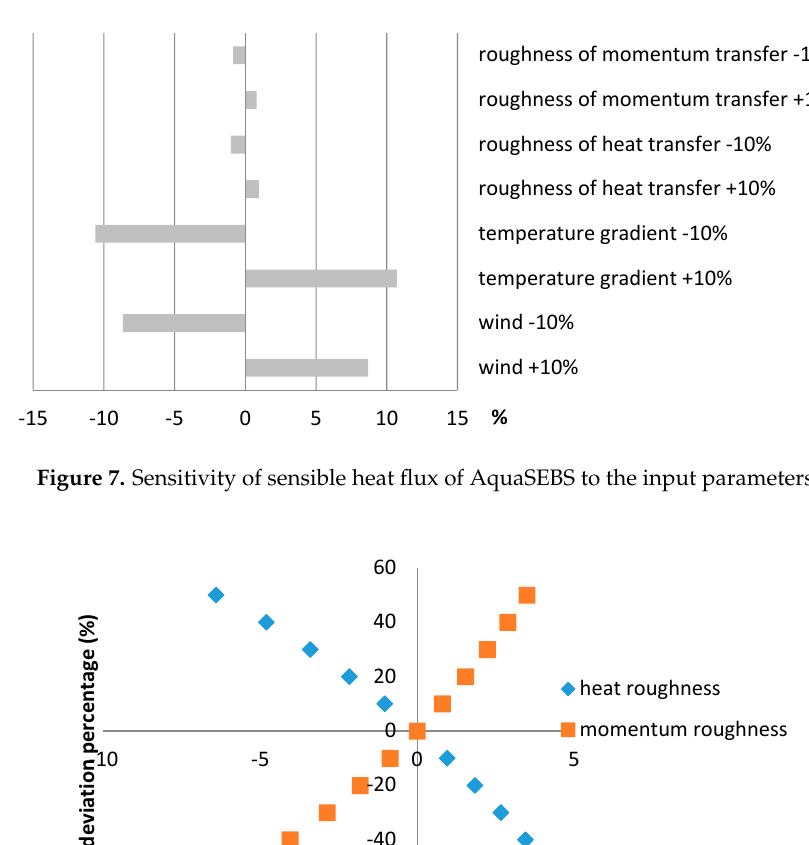
Figure 8. Sensitivity of estimated sensible heat to roughness heights for momentum and heat transfer.